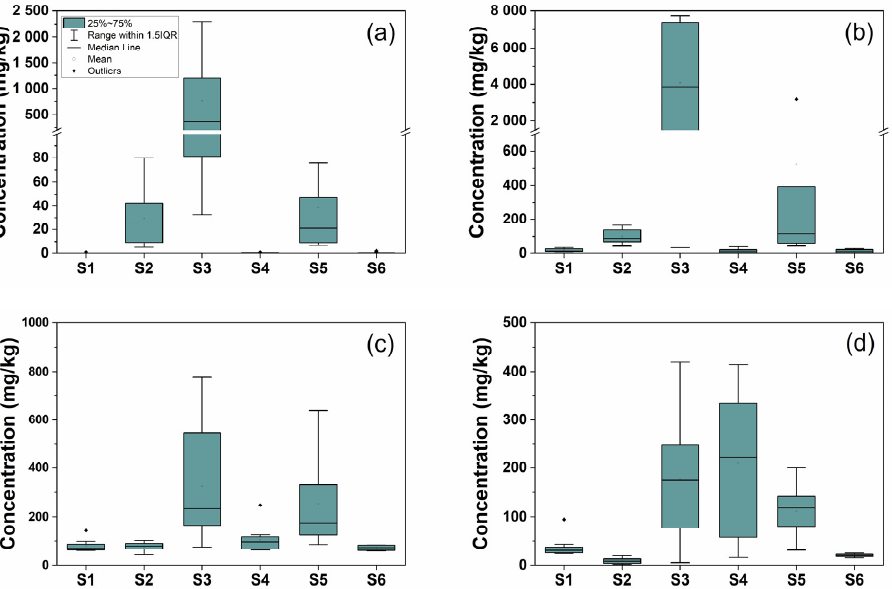
Figure 2. The concentrations of heavy metals in the soils at the different sampling points. ( a ) Cr(VI), ( b ) Total Cr, ( c ) Cu and ( d ) Zn.